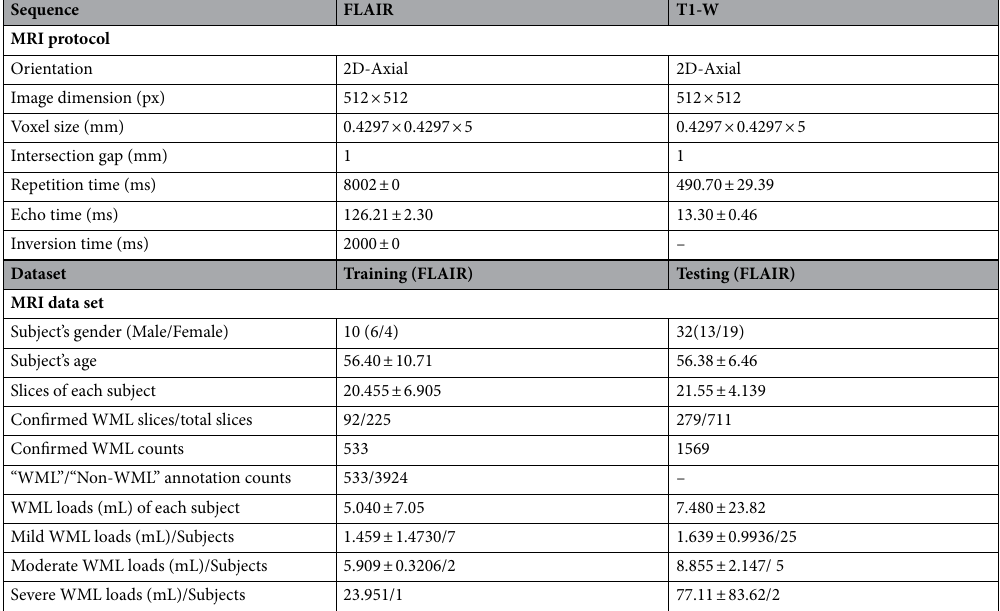
feature (see Table 4), calculated based on WML candidate intensities obtained from WML image patches, and (2) the texture feature from the GLCM embedded clustering strategy that we propose here, where we embed- ded k -means clustering in a gray level co-occurrence matrix (GLCM) calculation. In Fig. 6b, we compared the texture visualization between the original WML candidate image and the reconstructed image determined by k -means versus the quantile method (the existing linear scaling method), which demonstrated that k -means can recapitulate the detailed texture of the original image with greater fidelity, as highlighted by the green arrow. This shows that the clustering method can effectively scale the original image from 16 to 3 bits, while still retaining the global content. In addition, the k -means clustering algorithm has been successfully and widely used in various medical image segmentation applications such as WML segmentation 64,65 , brain lesion segmentation 66 , brain segmentation 67 , corpus callosum segmentation 68 , and brain tumour segmentation 69,70 . In our implementation, k -means was used to accurately cluster the intensity data of WML texture structure, so that the feature data in the next feature extraction process was more accurate in the GLCM calculation (see Fig. 1d). Therefore, the intensity of each image patch will be clustered as the input to the GLCM calculation. GLCM is a method of describing and digitizing image texture by finding the frequency of pixel pairs that appear in various spatial relationships (such as distance and direction) in an image. These frequencies was used to construct the gray-level spatial correlation matrix, also known as a co-occurrence matrix (CM) 71 , where the element of the co-occurrence matrix for a given clustered WML image patch N × M with L clustered grey levels can be defined as Eq. 1. Subsequently, the GLCM was constructed from each of the elements in the matrix of probabilities that pairs of pixels occurred in a given spatial relationship. For instance, Prob(x,y|∆x , ∆y) (see Eq. 2), which was computed based on the distance d ( ∆x , ∆y ) of two neighboring voxels in the clustered intensity image that co-occur at a given orientation (0°, 45°, 90°, and 135°).